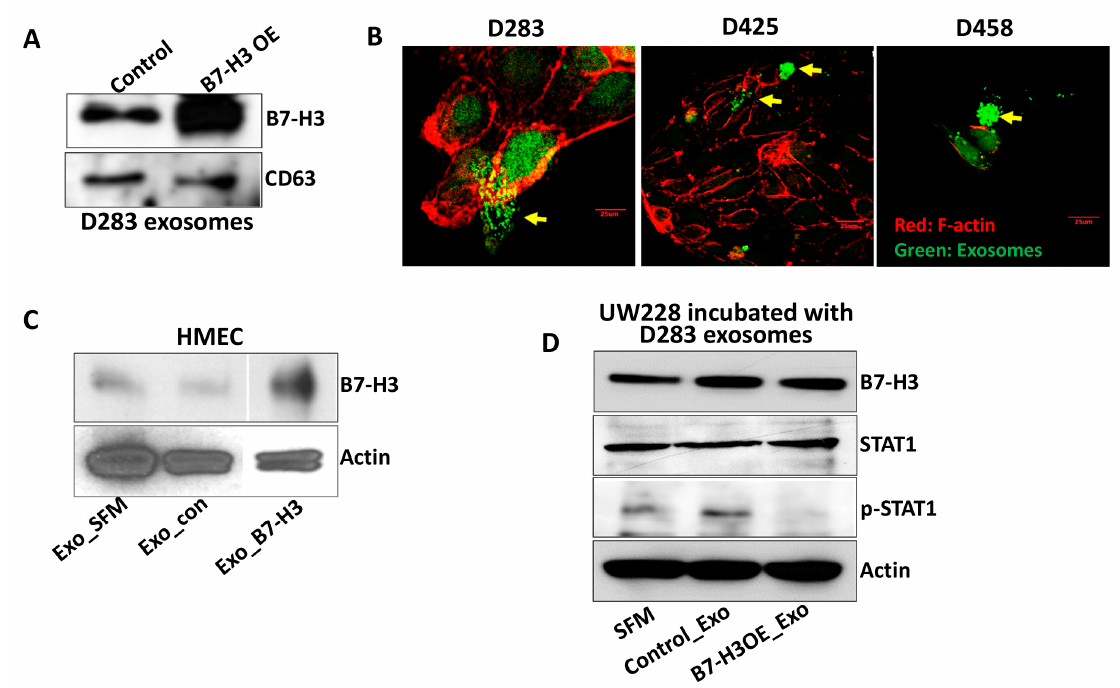
Figure 3. B7-H3 expression can be induced via MB-derived exosomes in recipient cells: ( A ) Western blot of isolated exosomes (5 µg/lane) from D283 cells showing increased B7-H3 presence in B7-H3 OE transfected cell-derived exosomes compared to control. CD63 used as exosomal loading control. ( B ) F-actin staining (red) of D283, D425, and D458 cells incubated with D283-derived B7-H3 OE exosomes (green). Briefly, 15 µg of exosomes (5 µg/well) were incubated with 0.5 µL of Calcein AM in SFM for 30 min in an Eppendorf tube and then overlaid on a 3-well chambered slide (ibidi, Fitchburg, WI) with 1 mL media containing D283, D425, and D458 cells for 6 h. Yellow arrows indicate likely areas of stained exosomes fusing with target cells. ( C ) Western blot of HMECs incubated (24 h) in SFM alone, with D283 control exosomes, or D283 B7-H3 OE exosomes showing increased B7-H3 expression intracellularly. Actin was used as a loading control. The B7-H3 and Actin blots shown here are cropped using PowerPoint for clear representation. Lane 3 from the original blots of both B7-H3 and Actin were cropped from the figure as it is not relevant to this study. Lane 4, which represents exosomes from B7-H3 overexpression (EXO_B7-H3 OE), is now represented as a single lane with actin as a loading control. The corresponding uncropped full-length blot is included in Figure S3. ( D ) Western blot of UW228 cells incubated (6 h) with SFM alone, D283 control exosomes, or D283 B7-H3 OE exosomes showing increased B7-H3 expression along with decreased STAT1 phosphorylation. Actin was used as a loading control.